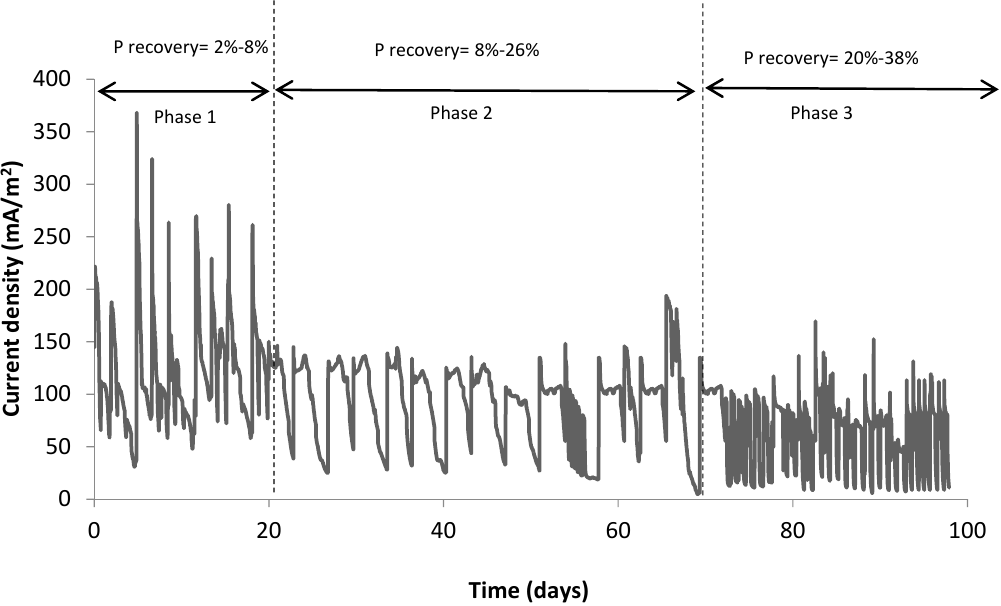
Figure 3. Impact of P recovery on current density.